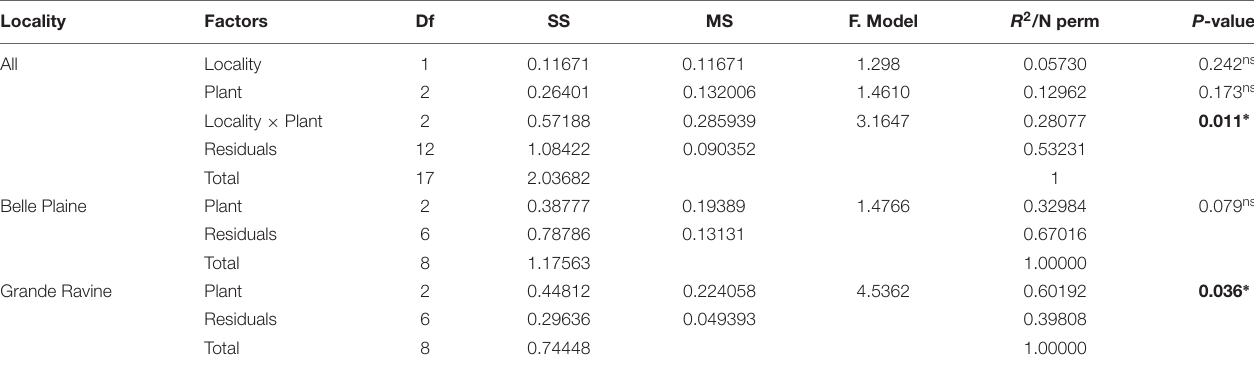
TABLE 1 | Impact of locality and plant type on arbuscular mycorrhizal (AM) fungal community structures in agroforestry systems.